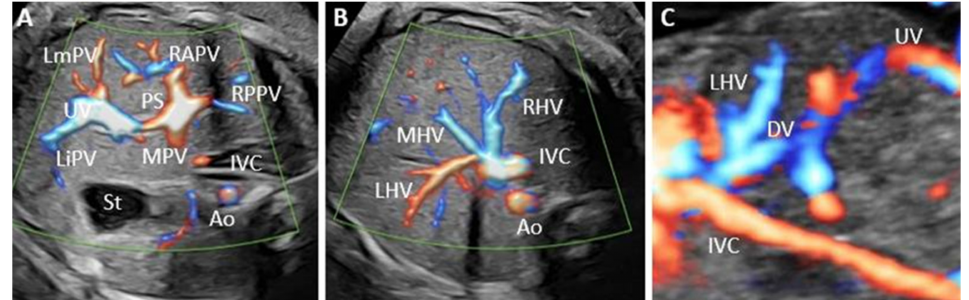
Figure 1. The typical aspect of the portal venous system (PVS), hepatic veins, and ductus venosus. ( A ) Transverse plane of the fetal abdomen, with high-definition directional power Doppler, applied to demonstrate the normal L-shaped UV confluence and PVS features. ( B ) Transverse plane allowed the evaluation of the left middle and right hepatic veins, aorta, and inferior vena cava. ( C ) Sagittal plane of the fetal thorax and abdomen, with the evaluation of the umbilical vein, left hepatic vein, ductus venosus, and inferior vena cava. UV, umbilical vein; RAPV, anterior branch of the right portal vein; RPPV, posterior branch of the right portal vein; LiPV, left portal vein inferior branch; LmPV, left portal vein medial branch; Ao, aorta; RHV, right hepatic vein; LHV, left hepatic vein; MHV, middle hepatic